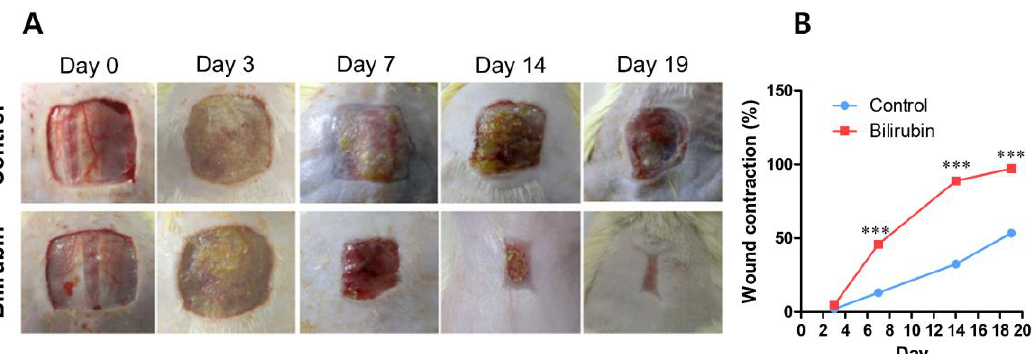
Figure 4. ( A ) Representative images of the wound treated with Bilirubin and ( B ) wound contraction after 19 days. Three asterisks (***) indicates p -value < 0.001. Reproduced with permission from Ram et al., “Bilirubin modulated cytokines, growth factors and angiogenesis to improve cutaneous wound healing process in diabetic rats”, published by Elsevier, 2016 [138].